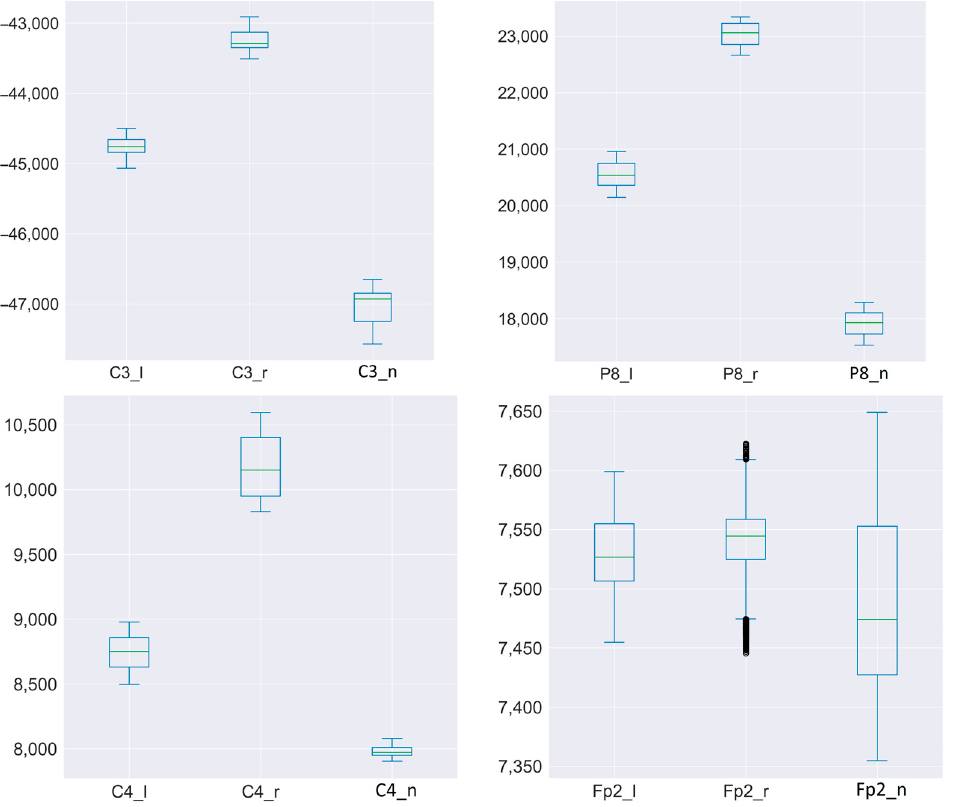
Figure 6. Distribution of signal magnitude for one of the subjects for three states (rest, movement to the left, movement to the right).